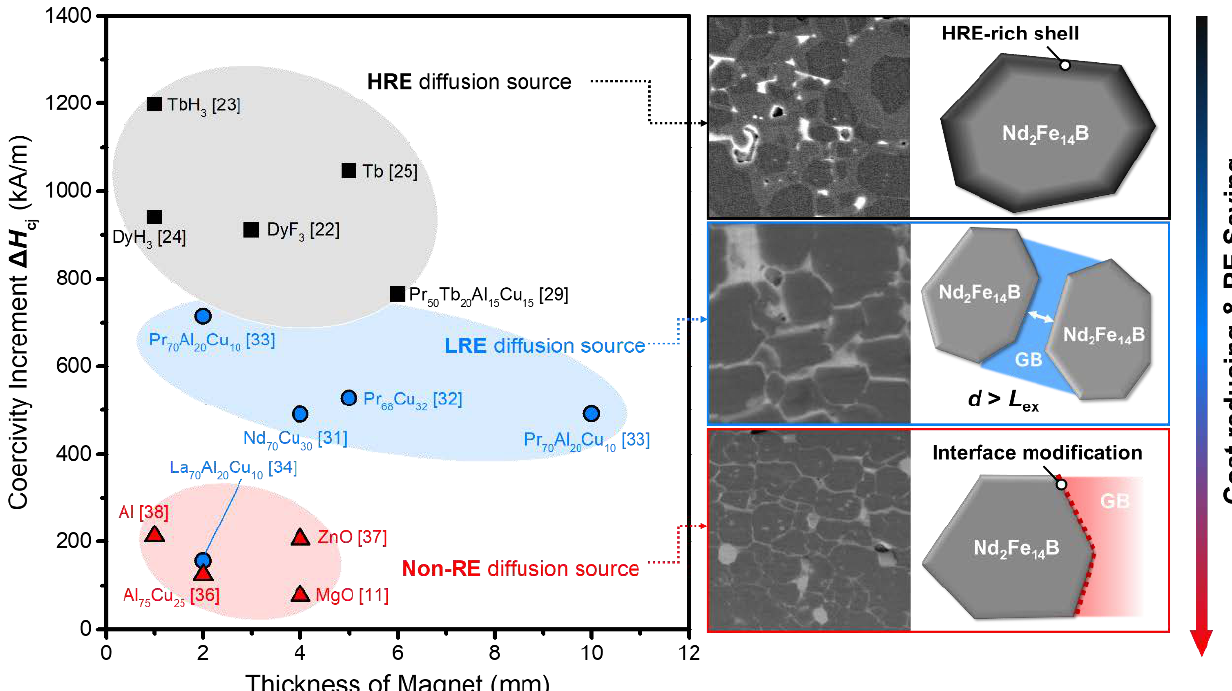
Figure 1. A comparison of coercivity increment in sintered magnets for different types of diffusion sources, including HRE, LRE, and non-RE based metals, compounds and alloys. The main mechanisms of the three generations of diffusion sources on coercivity enhancement are